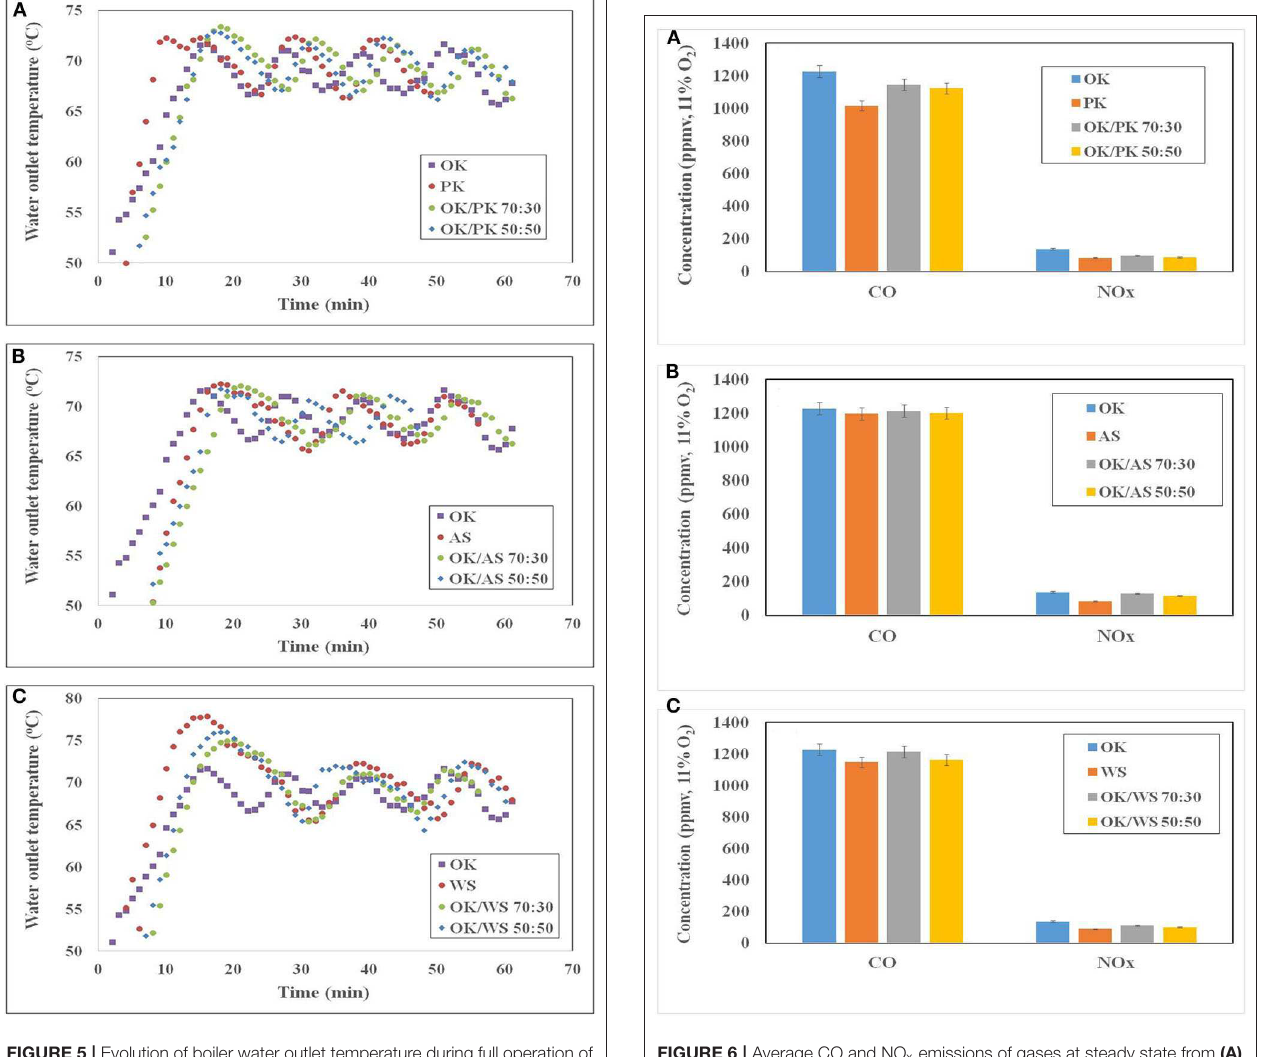
FIGURE 5 | Evolution of boiler water outlet temperature during full operation of the unit for (A) OK/PK, (B) OK/AS, and (C) OK/WS mixtures.